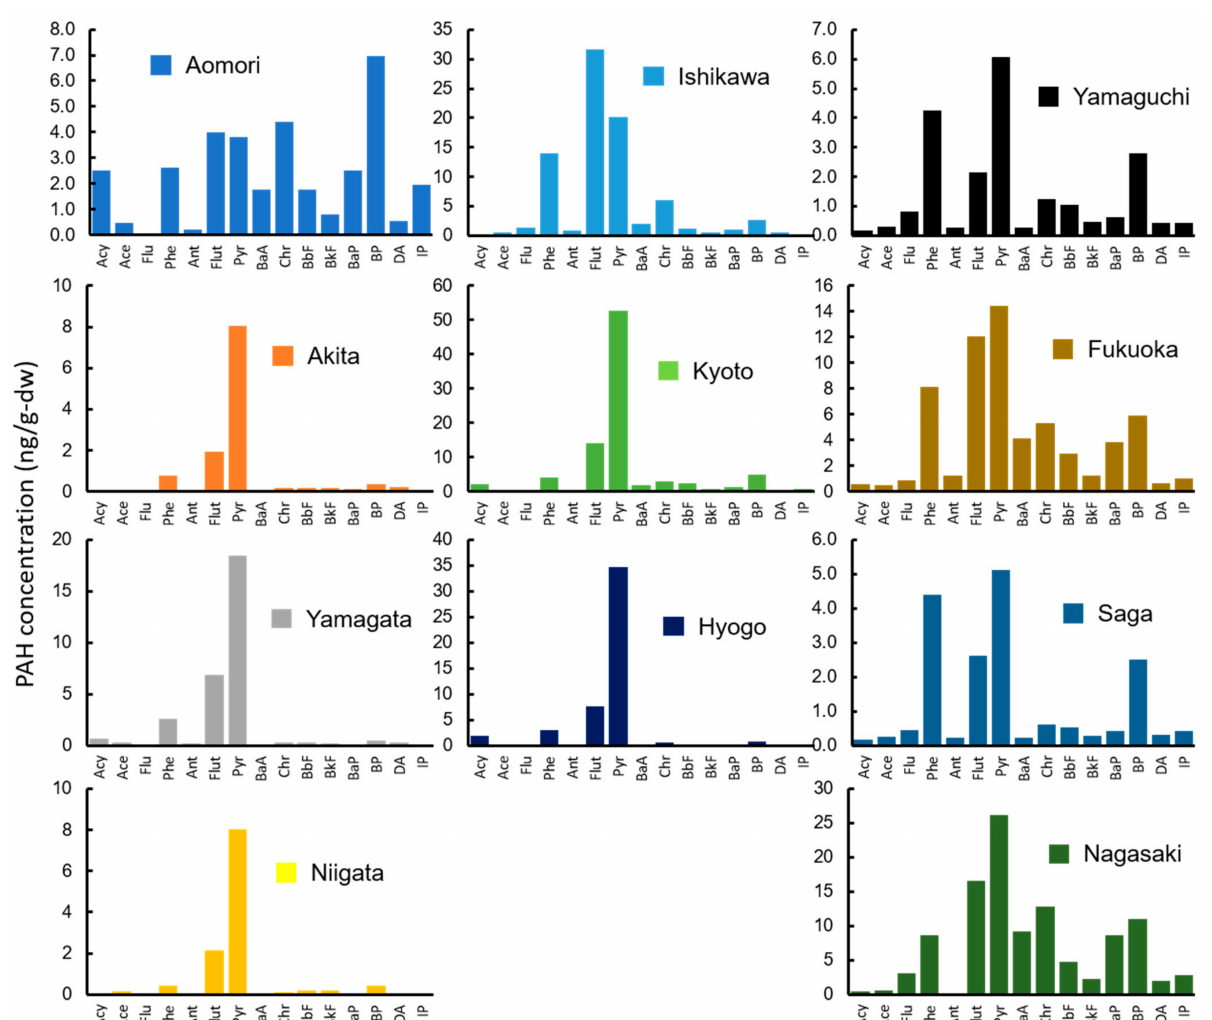
Figure 6. Concentrations of 15 PAHs in drifting seaweed (ng/g-dw) collected from 11 sampling sites. Samples could not be found at the Shimane Prefecture site.